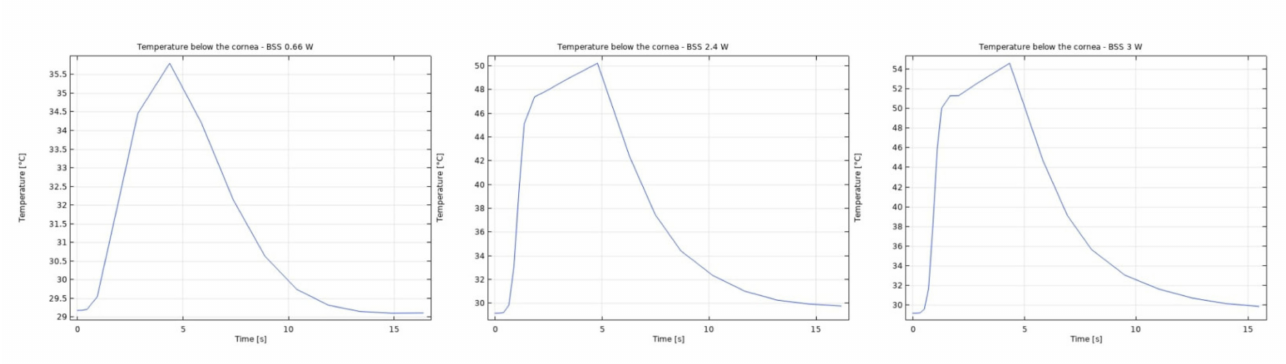
Figure 10. Temperature at the point probe with BSS after 5 s of 0.66 W, 2.4 W and 3 W